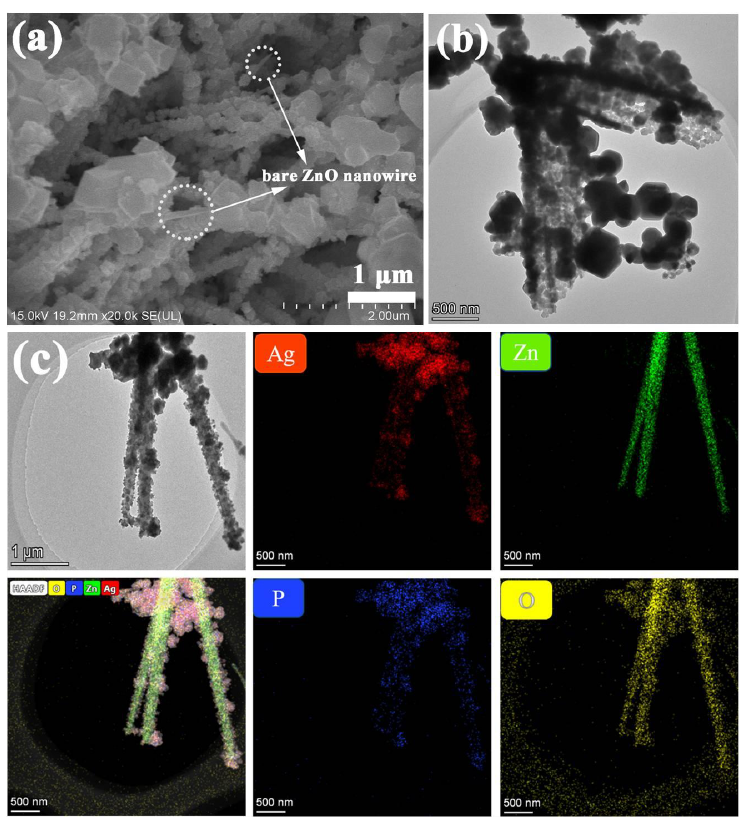
Figure 4. SEM image ( a ), TEM image, ( b ) and corresponding elemental mappings ( c ) of the CC/ZnO@Ag 3 PO 4 composite, which show distribution of the Ag, Zn, P, and O elements.